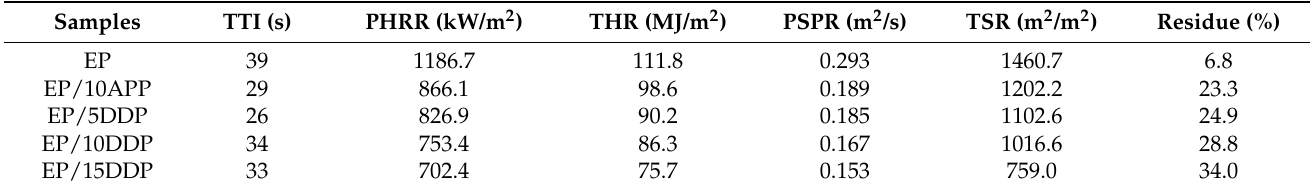
Table 3. Cone calorimeter data of the flame-retarded EP blends at a heat flux of 50 kw/m 2